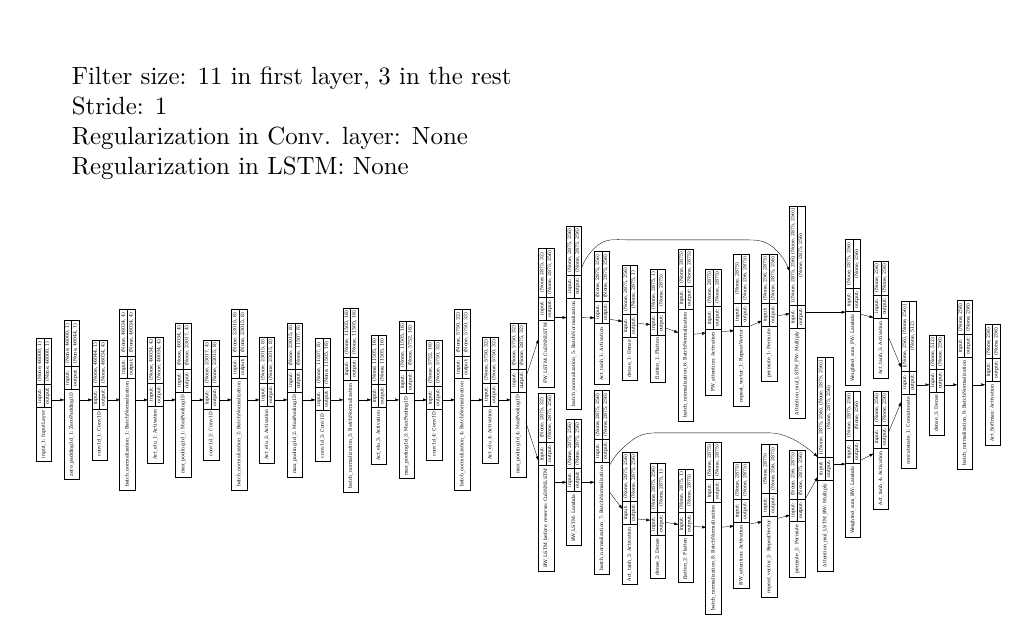
Figure 31: Network for desynchronized AT128-F.